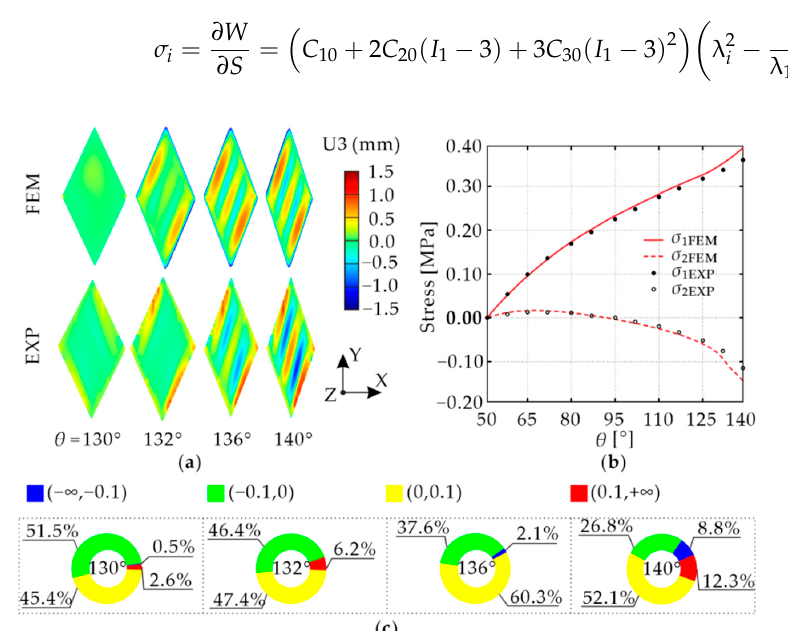
Figure 6. Comparison of numerical and experimental results: ( a ) deformation process; ( b ) principal stress versus morphing angle curves; ( c ) pie graphs of the configuration errors.